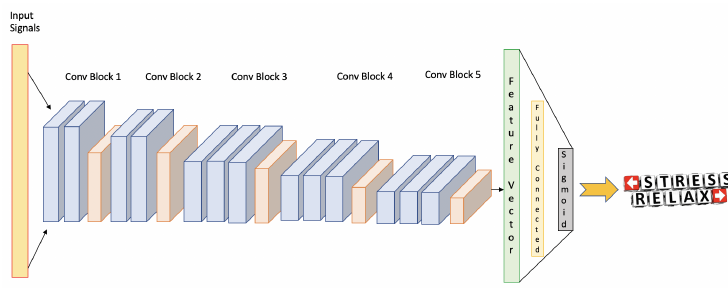
Figure 2. Overview of the CNN